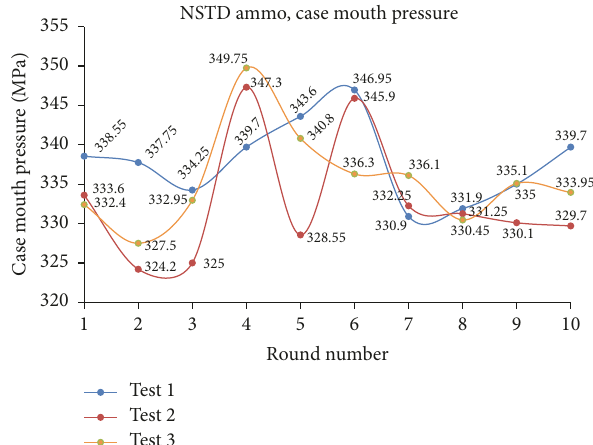
Figure 28: Case mouth pressure measured with piezo sensor using nonstandard ammunition.